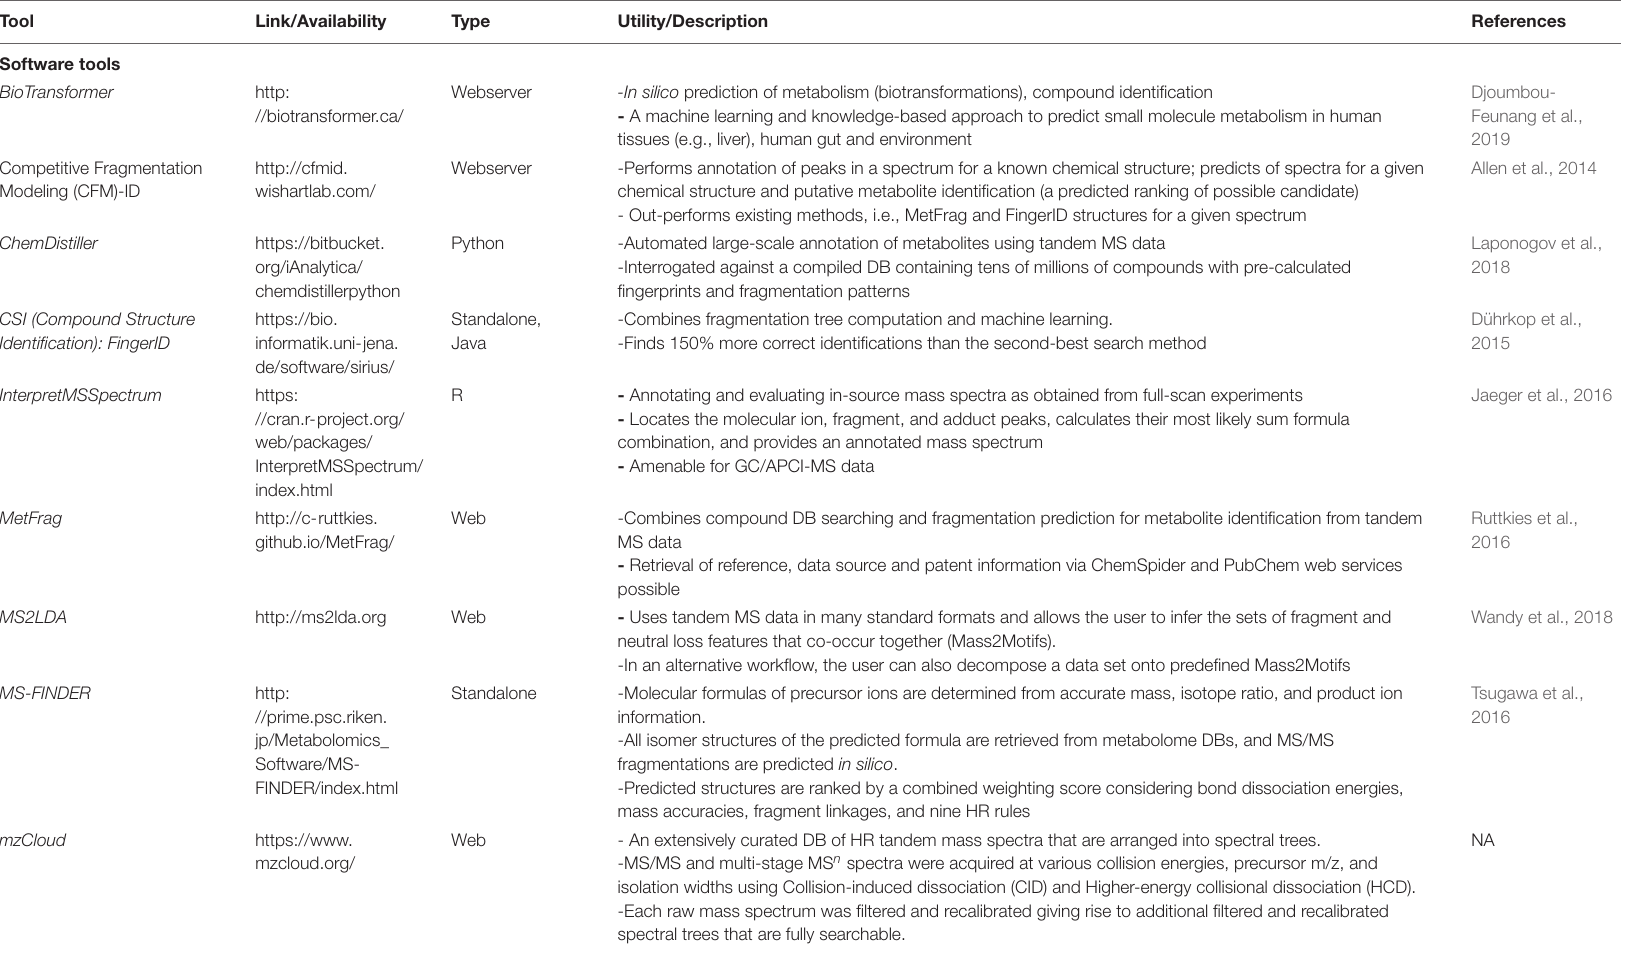
TABLE 3 | List of software tools, resources and chemical and spectral databases for exposomics